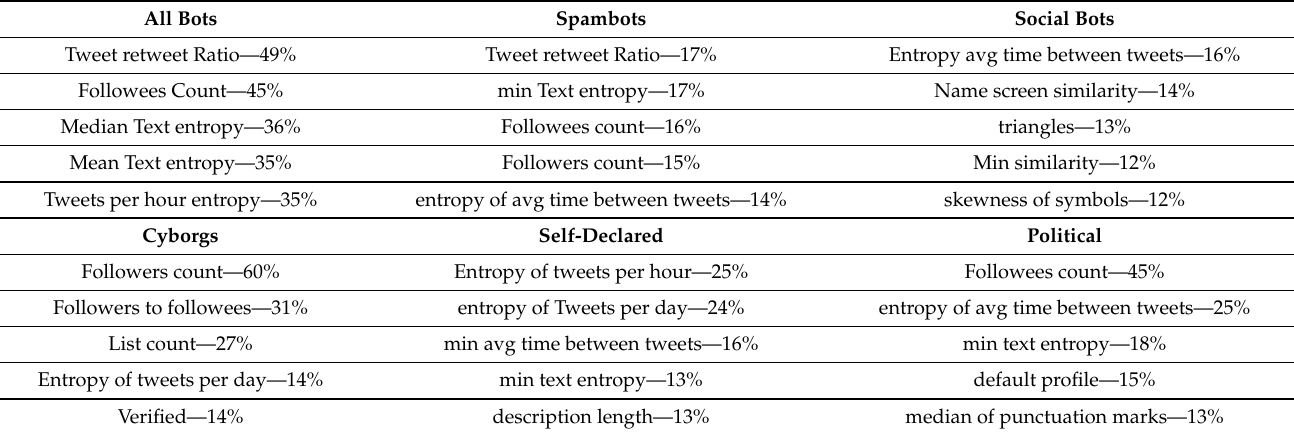
Table 9. Five most important features that defined the prediction of each bot type, according to our explainer model. The ratio refers to the number of times each feature was present in the five most important features for 200